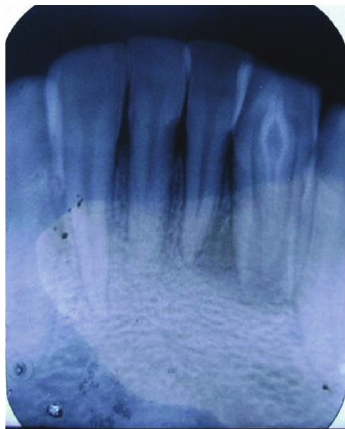
Figure 3: Initial radiograph showing DI type II with immature apex in relation to 32 and periradicular lesion associated with 31 and 32.